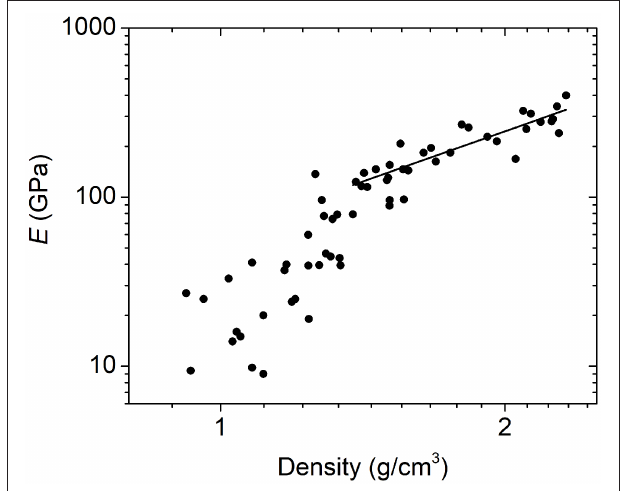
FIGURE 6 | Logarithmic plot of Young’s modulus as a function of density for a-BC:H films yielding an E ∝ D 2.0 relationship above 1.3 g/cm 3 .